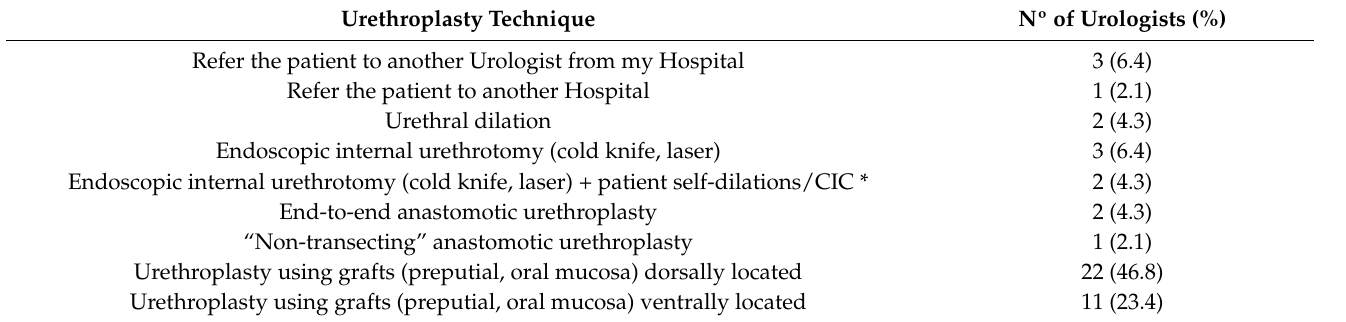
Table 7. How would you manage in your clinical practice a 35 year-old male, uncircumcised, with